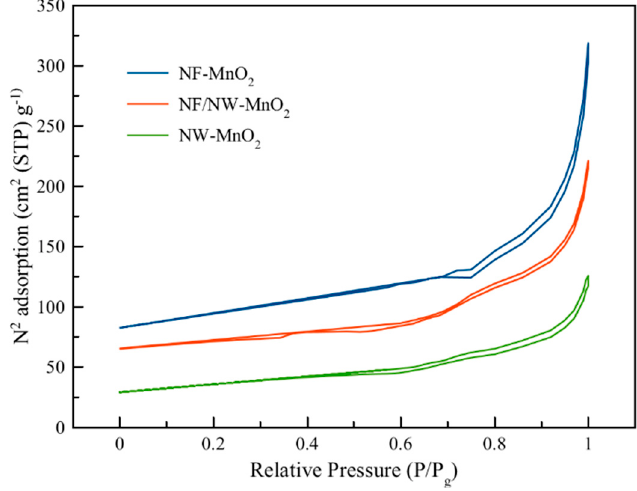
/ desorption isotherms of all the Figure 2. N 2 adsorption/desorption isotherms of all the samples. Figure 2. N 2 adsorption